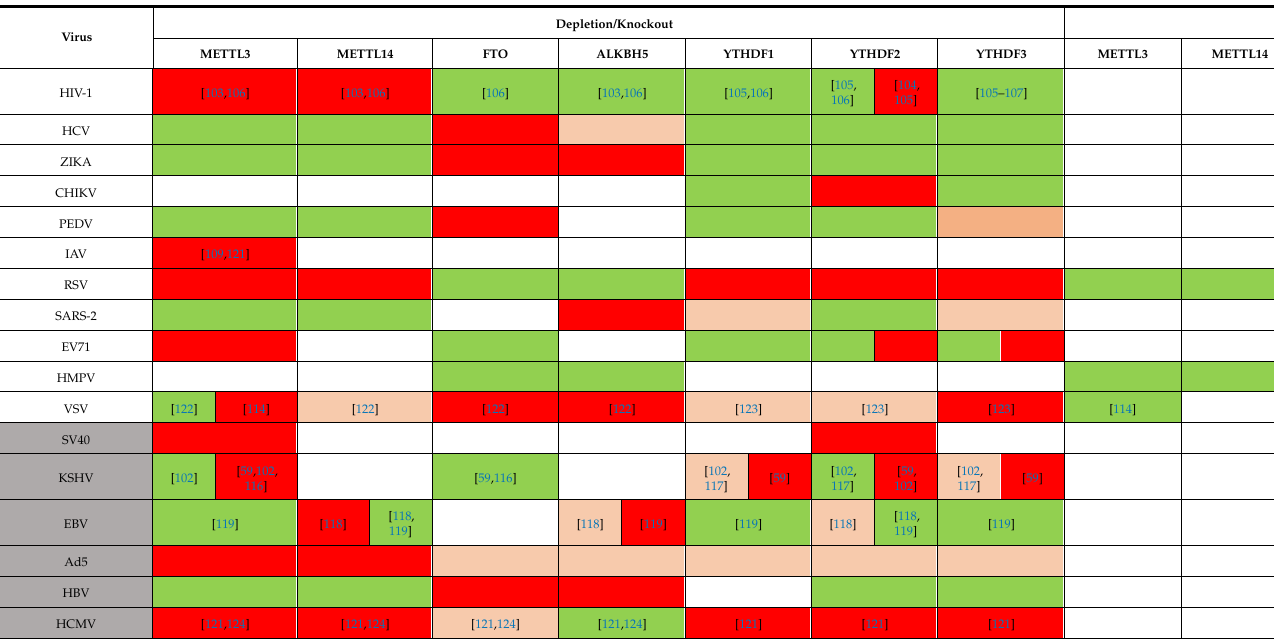
Table 2. Effects observed on viral replication after manipulation of the cellular m 6 A machinery. Boxes shaded in green indicate enhanced viral replication, while in red indicate reduced viral replication. Boxes shaded in orange indicate that there was no significant effect on viral replication. DNA viruses are shaded in grey boxes. HIV-1: [103–107]. HCV: [67]. ZIKV: